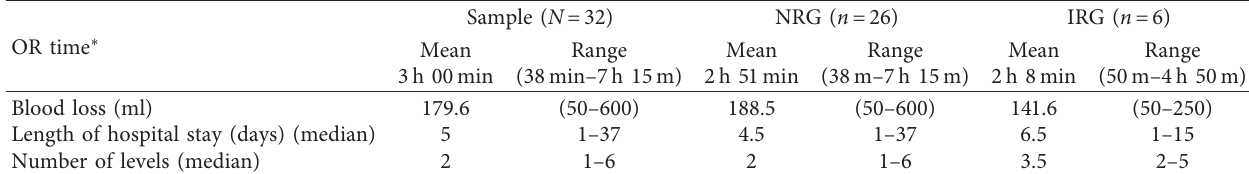
Table 3: Operative details.